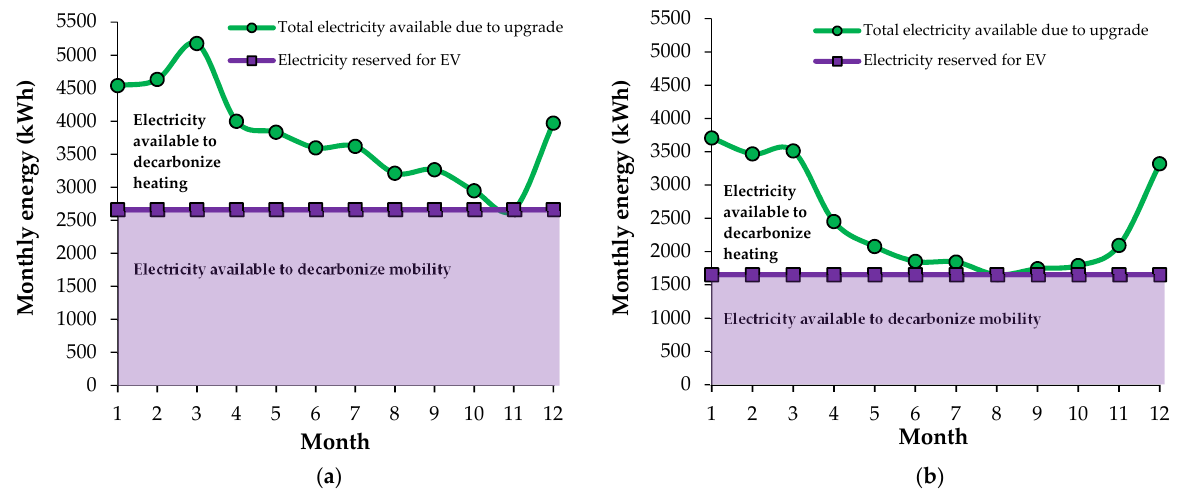
Figure 6. Energy profile that is made available for mobility and heating decarbonization by upgrading to: ( a ) a retrofitted house and ( b ) a rebuilt house.